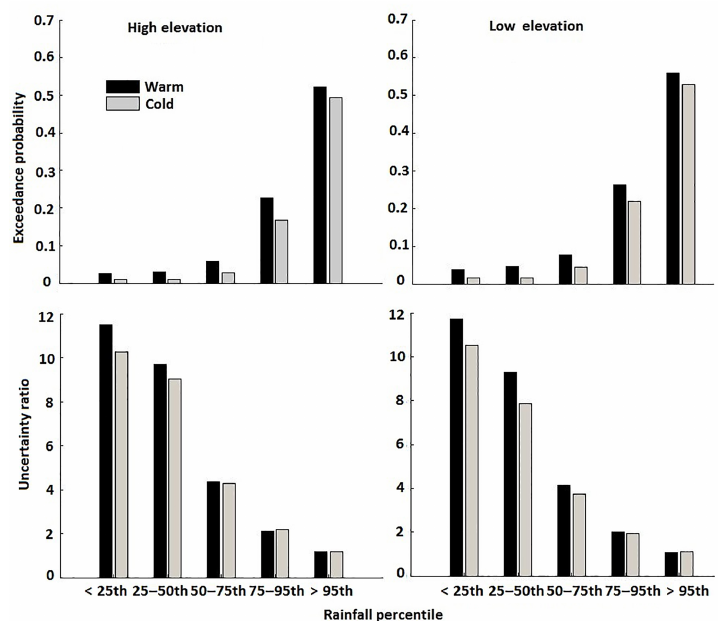
Figure 8. Exceedance probability and uncertainty ratio for warm and cold seasons.